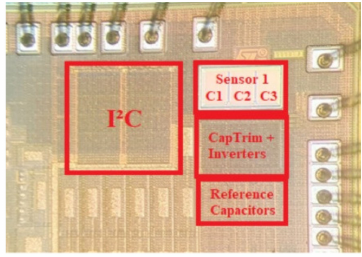
Figure 10. Microphotograph of the